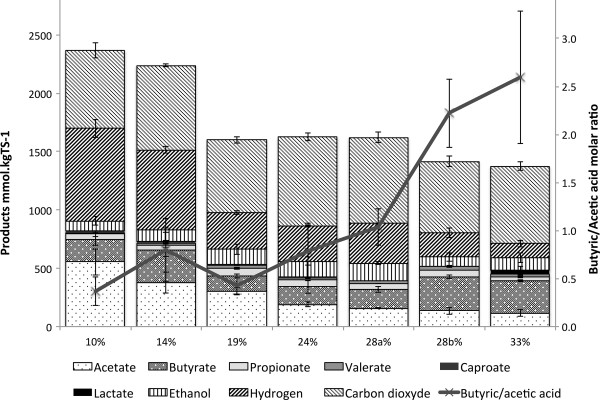
Distribution of fermentative products and butyric/acetic acid ratio for the six TS contents tested. These metabolites were measured after 11 days of reaction, expressed in mole unit, and reported on the initial TS content of the straw. The sum of fermentative products indicates the straw conversion yield. The butyric/acetic acid ratio indicated a metabolic shift that occurred at 28% TS. TS, total solids.